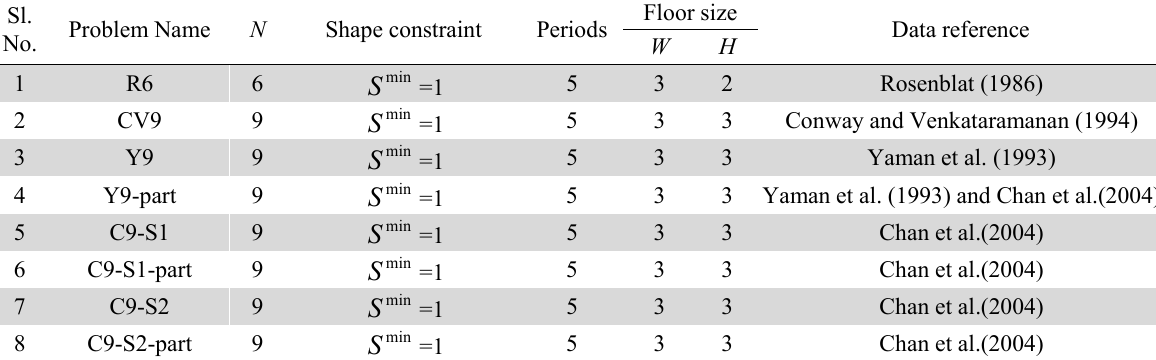
Summary of equal area dynamic facility layout problem data sets